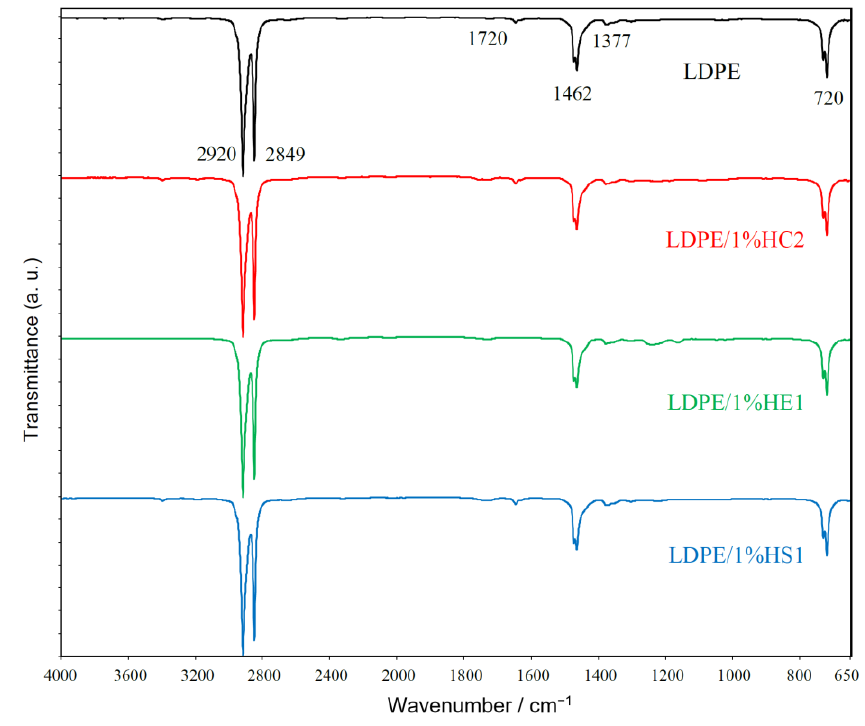
Figure 6. FT-IR spectra of LDPE and prepared LDPE/hematite